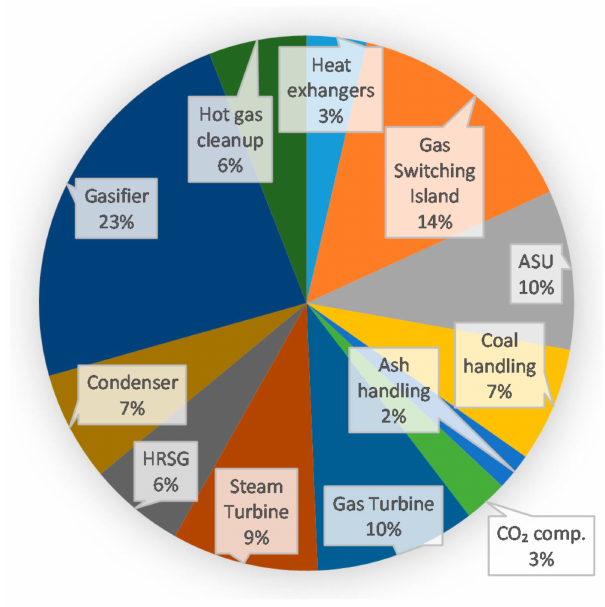
Figure 6. Total installed cost breakdown for the GSC